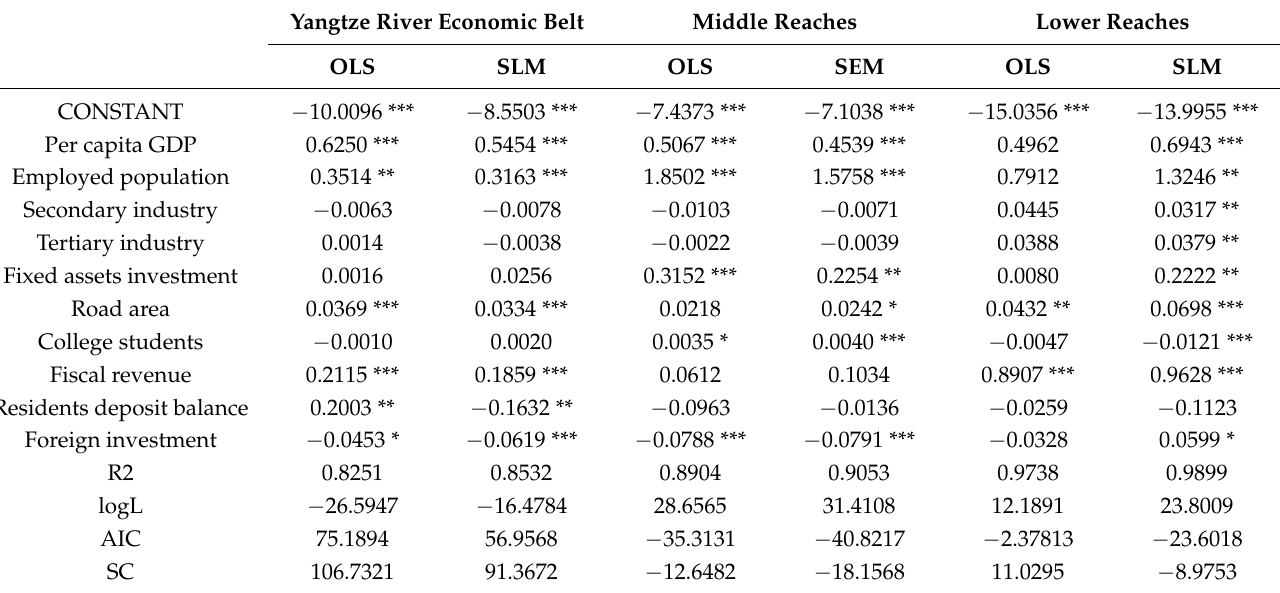
Table 3. OLS, SLM, and SEM of the spatial measurement model